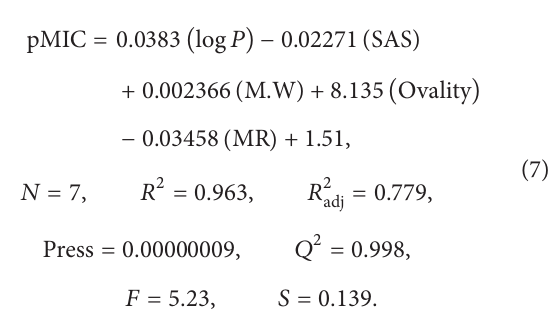
in Table 7 and plot of calculated and observed antibacterial activity is given in Figure 5.